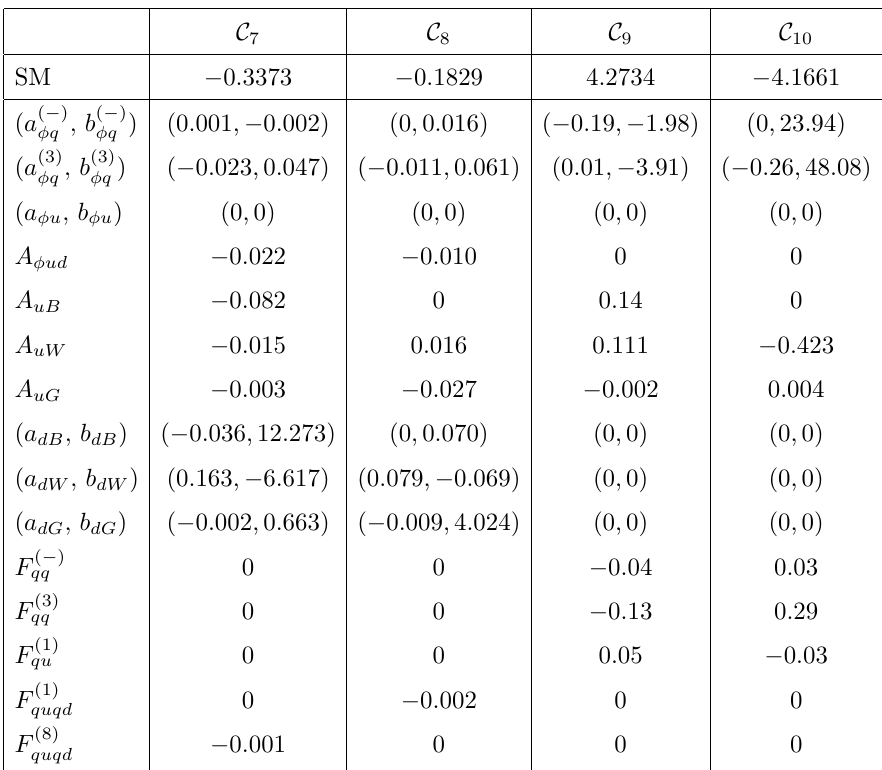
Table 7 . Contributions of SMEFT coefficients C ( m t ) to the real part of the WET coefficients C ( m b ) in MFV with up-alignment. The SMEFT coefficients are matched onto WET at µ = m Z at one-loop level in the electroweak theory and then RG-evolved down to µ = m scale of new physics has been set to Λ = 1 TeV . Contributions to C the operators considered in this